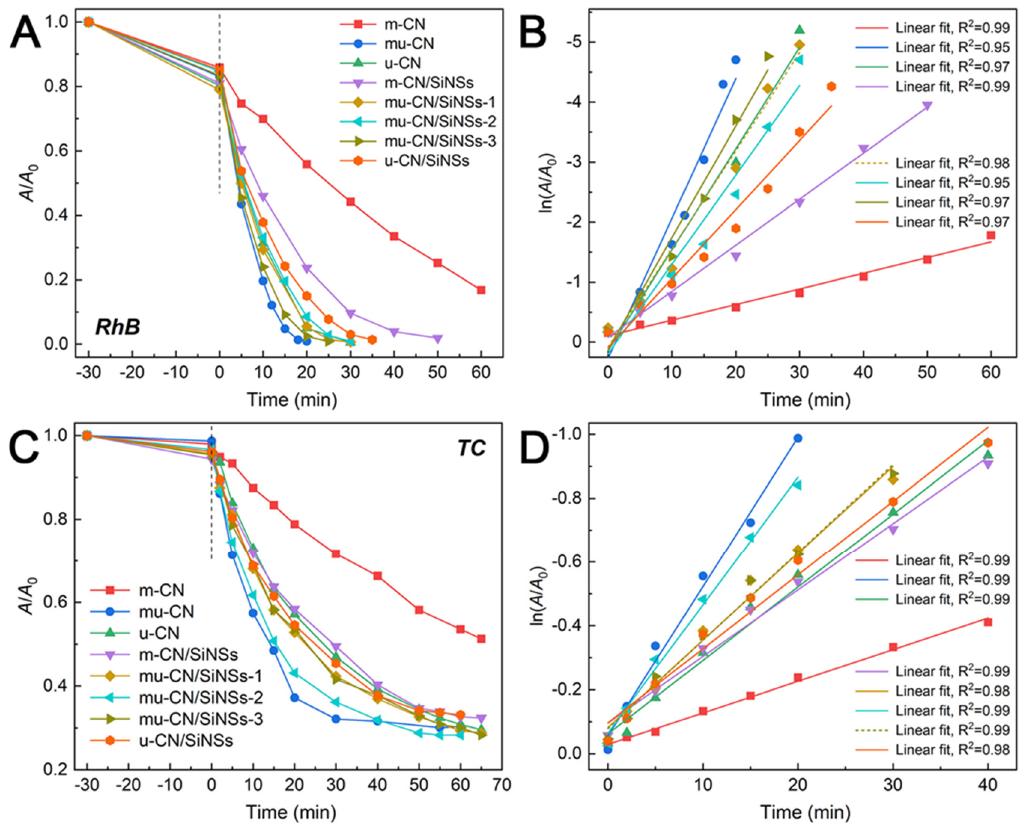
Figure 6. A / A 0 and ln( A / A 0 ) versus reaction time for the photocatalytic degradation of ( A , B ) RhB and ( C , D ) TC under visible-light irradiation over the